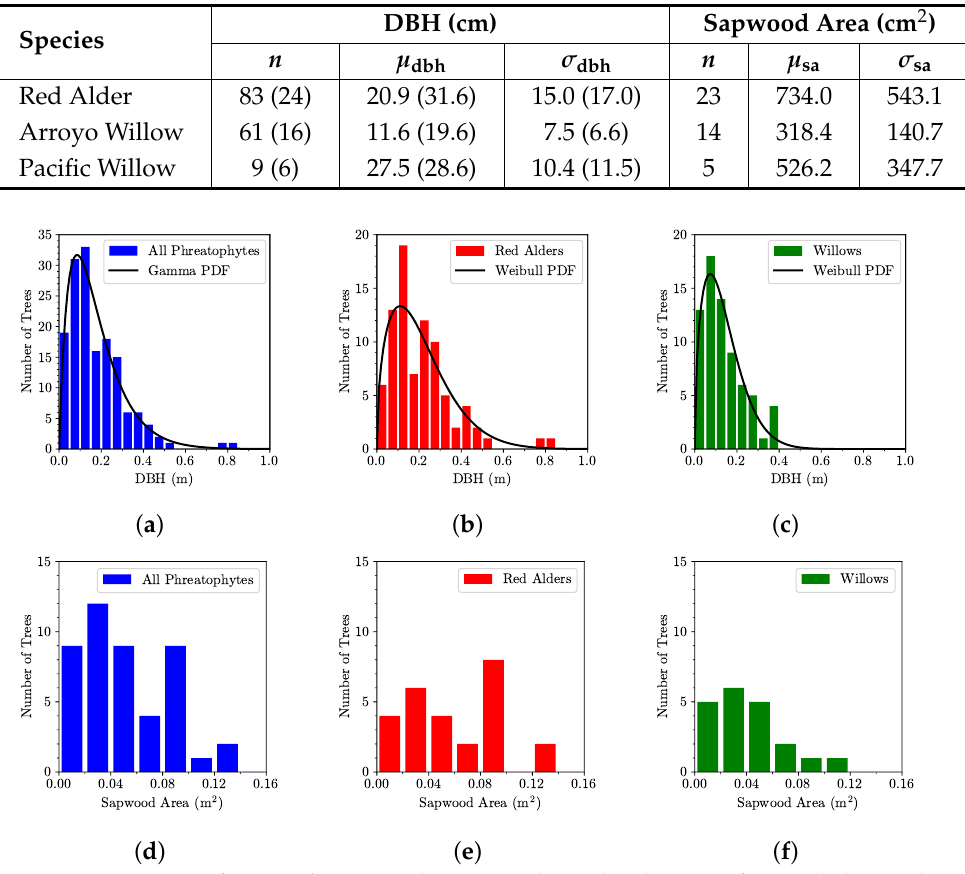
Figure 5. Histograms of measured tree stem diameters at breast height (DBH) for ( a ) all phreatophytes, ( b ) red alders, and ( c ) willows within the six sample plots, and histograms of measured main stem sapwood areas for ( d ) all phreatophytes, ( e ) red alders, and ( f ) willows within the six sample